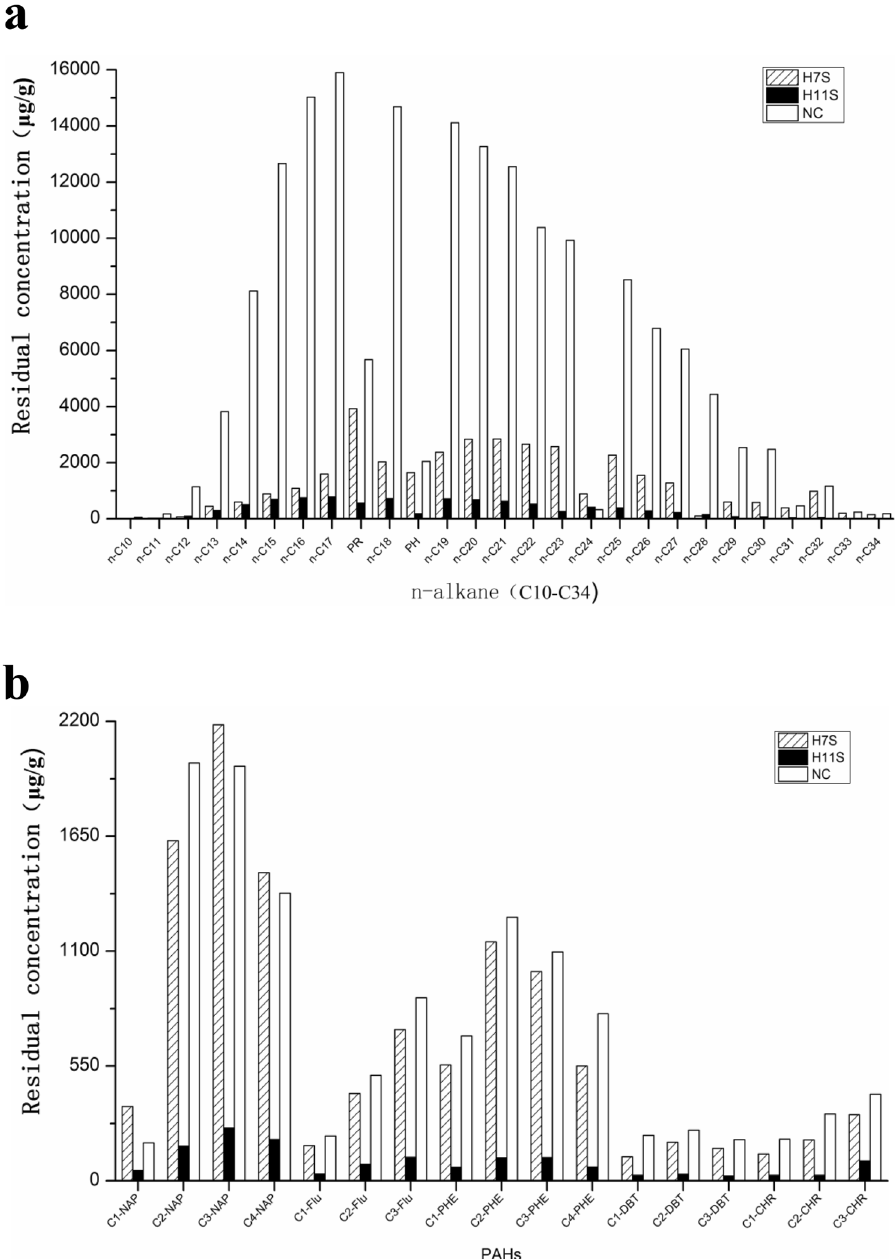
Figure 3. The n-alkanes and PAHs residual concentration of the crude oil after biodegradation by two enrichment cultures ( a ) n -Cm: alkane with m carbon atom, for instance, n -C16 is alkane with 16 carbon atom; "PR" is pristane, "PH" is phytane. ( b ) The concentrations of PAHs after the biodegradation by the 5 strains (NAP, FLU, DBT, PHE, and CHR represent for naphthalene, fluorine, dibenzothiophene, phenanthrene, chrysene, respectively. C1(C2, C3, C4)-NAP, alkylated naphthalene with straight-chain of 1 ~ 4 carbon atoms; C1(C2, C3)- FLU, alkylated fluorene with straight-chain of 1 ~ 3 carbon atoms; C1(C2, C3)-DBT, alkylated dibenantherene with straight-chain of 1 ~ 3 carbon atoms; C1(C2, C3, C4)-PHE, alkylated phenanthrene with straight-chain of 1 ~ 4 carbon atoms; C1(C2)-CHR, alkylated chrysene with straight-chain of 1 ~ 2 carbon